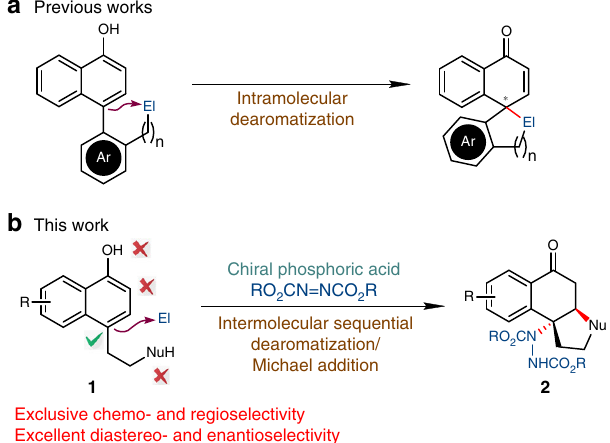
Fig. 1 Catalytic Asymmetric Dearomatization of α -Naphthols at the C4 Position. a Intramolecular dearomatization. b Intermolecular